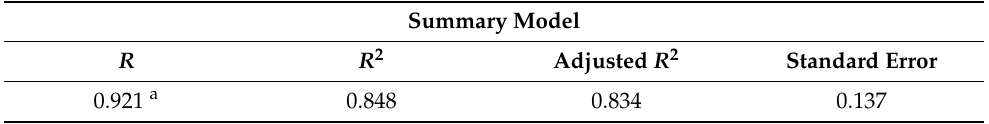
Table 7. Determination coefficients for UCS model.